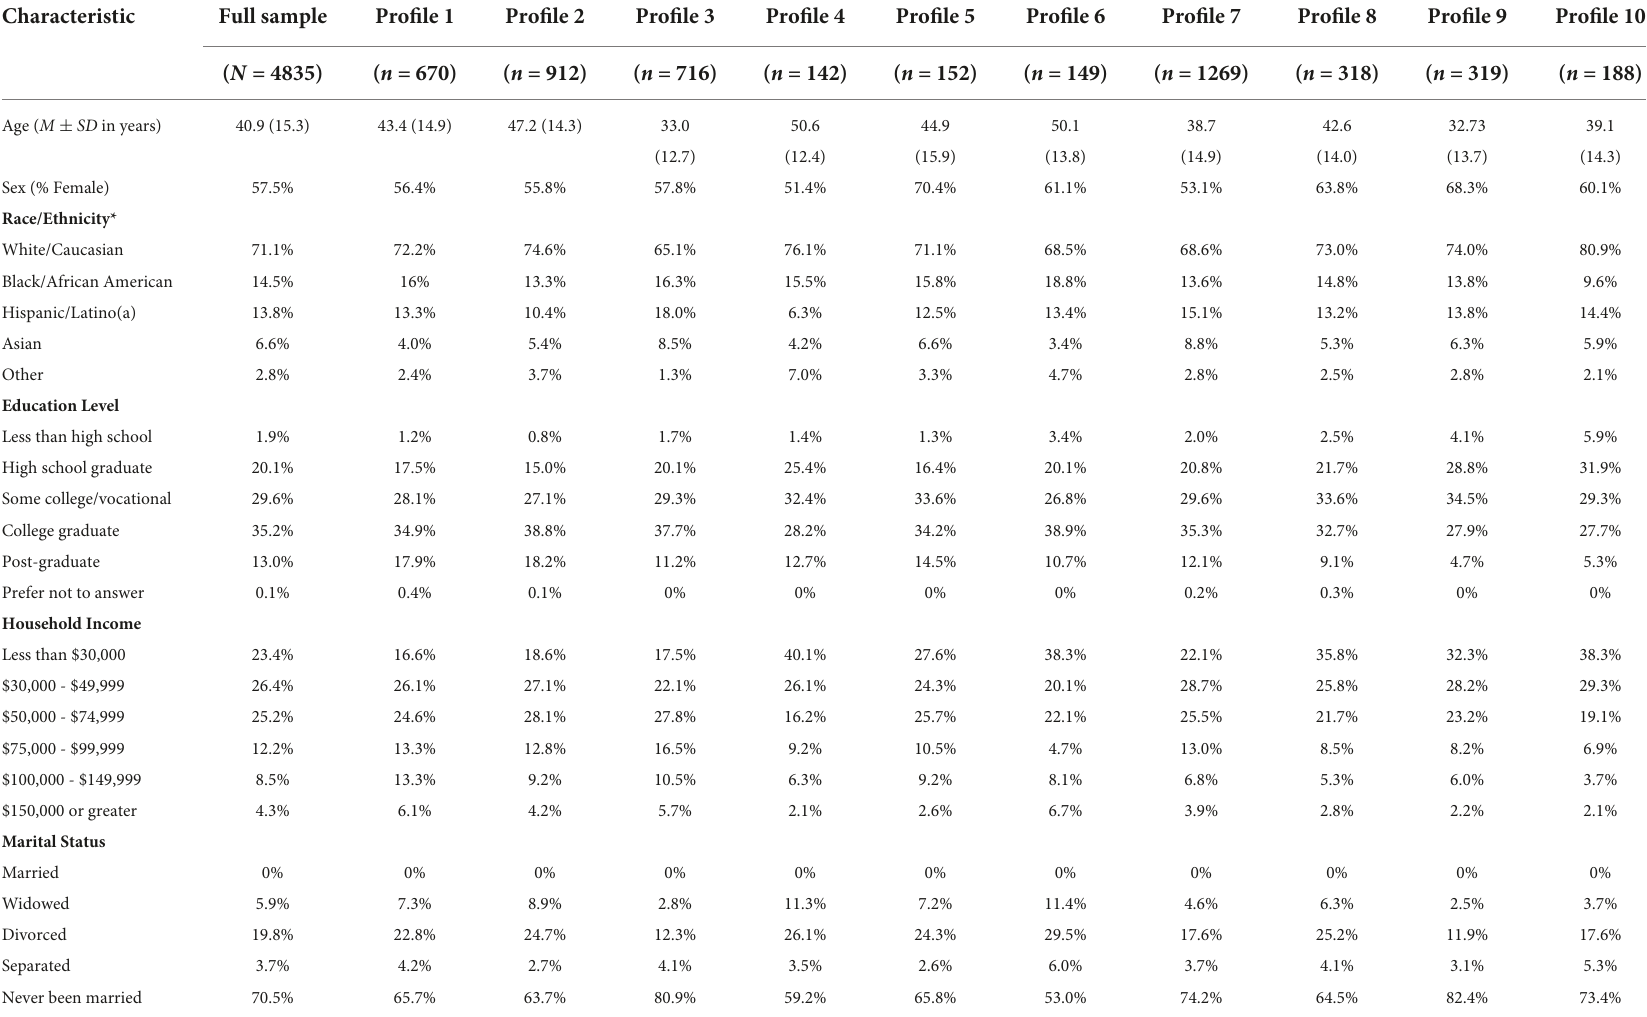
TABLE 1 Participant demographic